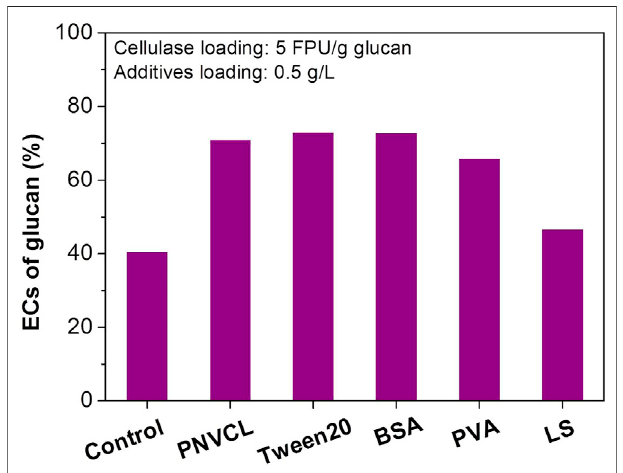
FIGURE 3 | Effects of different additives on the enzymatic hydrolysis ef fi ciencies of PSA-Ba substrate. The β -glucosidase loading is 7.5 CBU/g glucan. PNVCL, BSA, PVA and LS are the abbreviations of poly(N-vinylcaprolactam), bovine serum albumin, polyvinyl alcohol and lignosulfonate, respectively. The molecular weight of PNVCL and pH value of acetate buffer solution used here is the 1.3 kDa and 5, respectively.